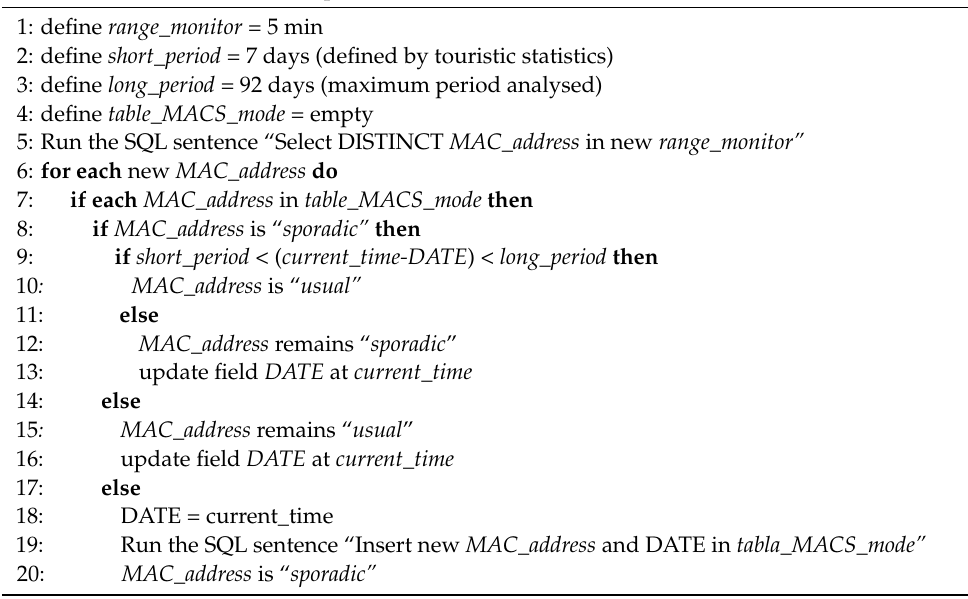
Algorithm 2. Process of classifying mobile devices into usual or sporadic, depending on the on the Wi-Fi connection detection